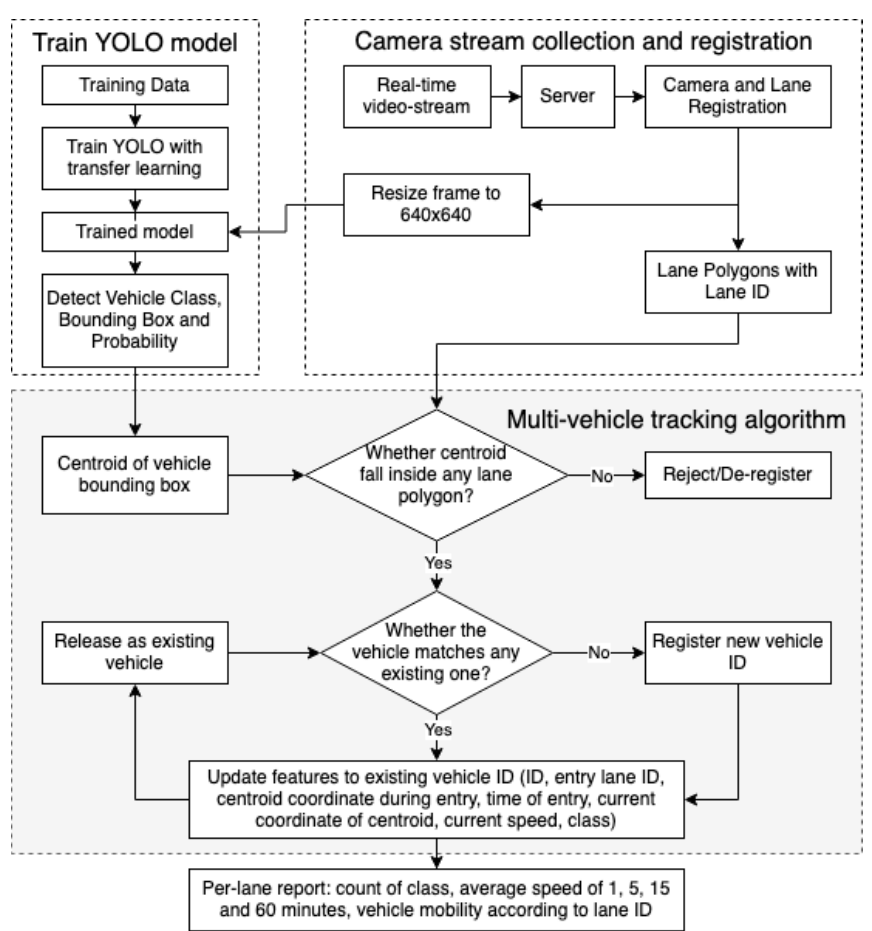
Figure 1. Multi-vehicle tracking algorithm for the lane-based count and speed detection of